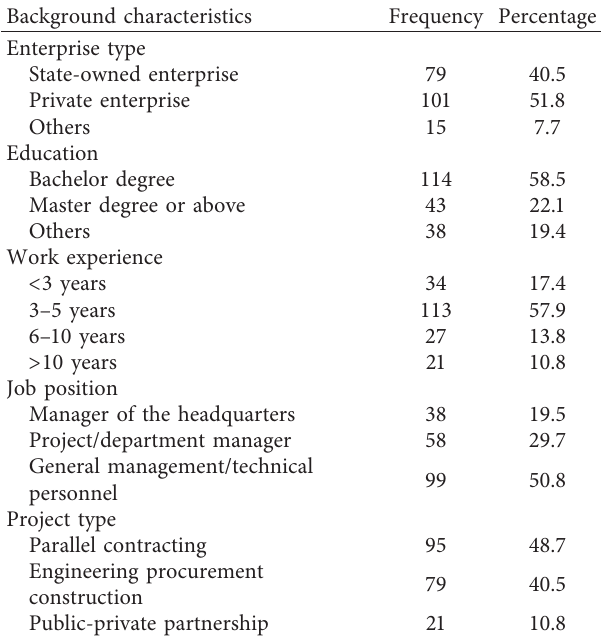
Table 2: Characteristics of respondents and their projects. Background